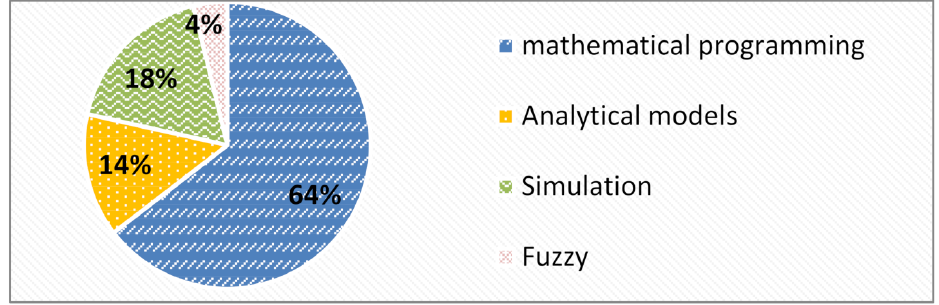
Figure 10. Solving methods used in